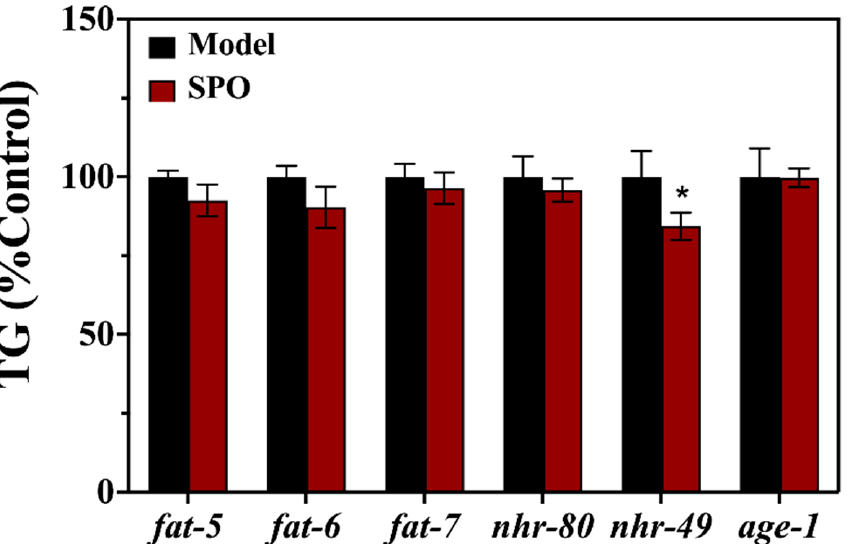
Figure 7. Effects of SPO on TG in mutants. All data are expressed as mean ± SD. The Student’s t -test was used for comparison, relative to model * p < 0.05.